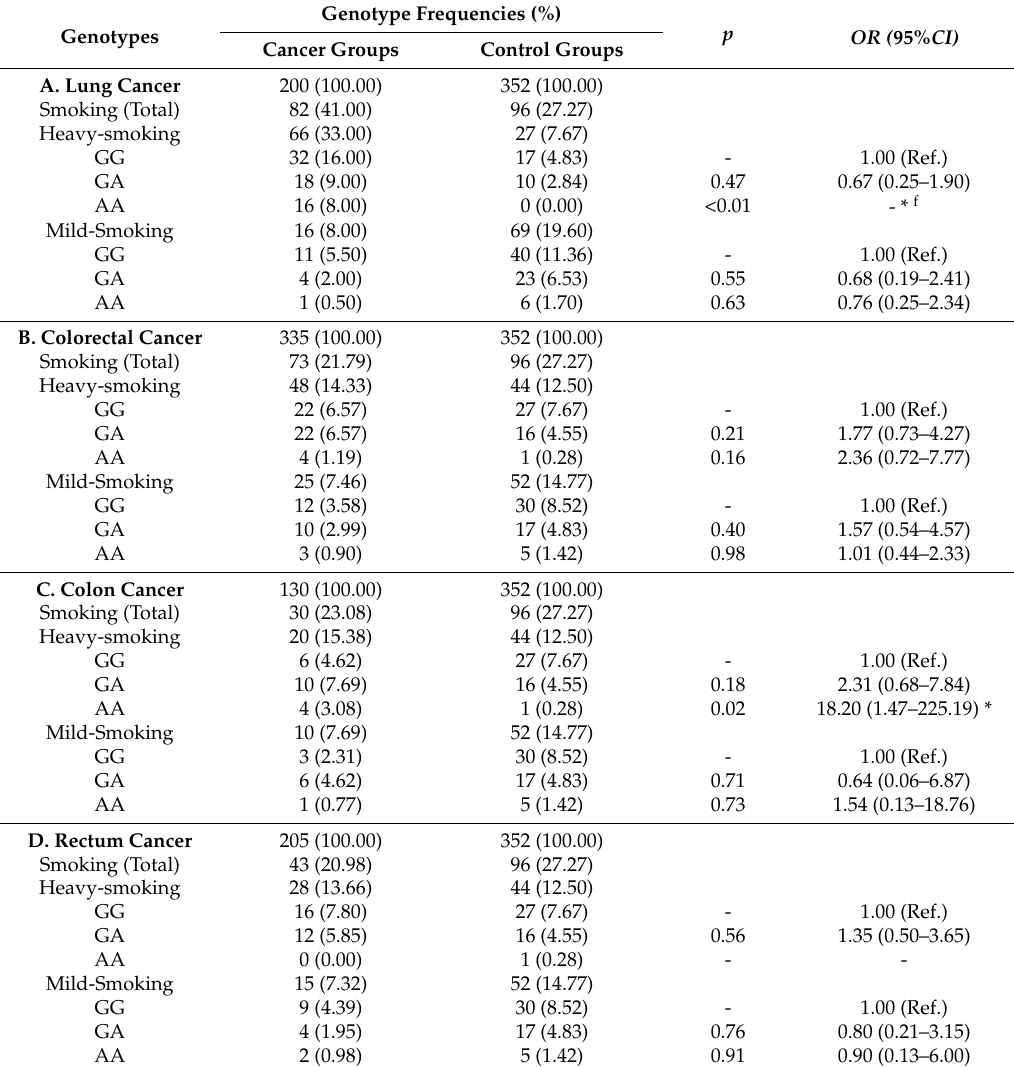
Table 8. Analysis for smoking status difference (heavy and mild smoking) in LOX G473A genotype frequency